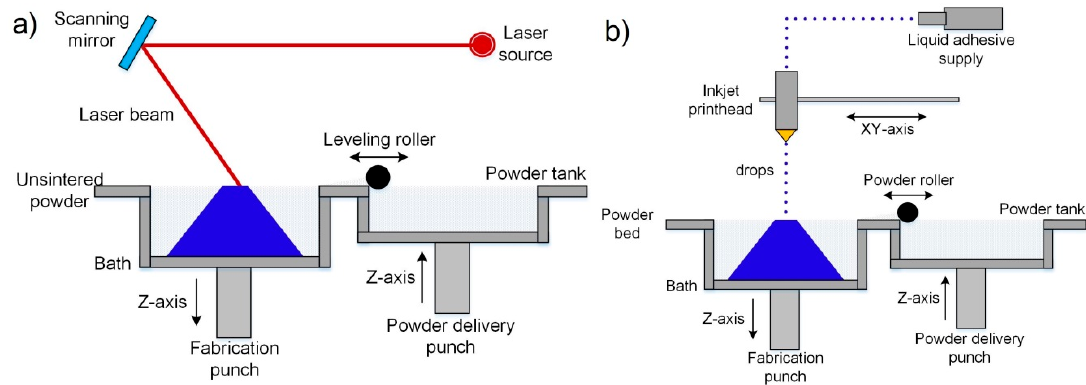
Figure 2. Schematic diagrams of powder-based additive manufacturing (AM) technologies main methods: ( a ) SLS and SLM; ( b ) BJ. Adapted from [44], with permission from Wiley-VCH Verlag GmbH and Co. KGaA, Weinheim, 2018.